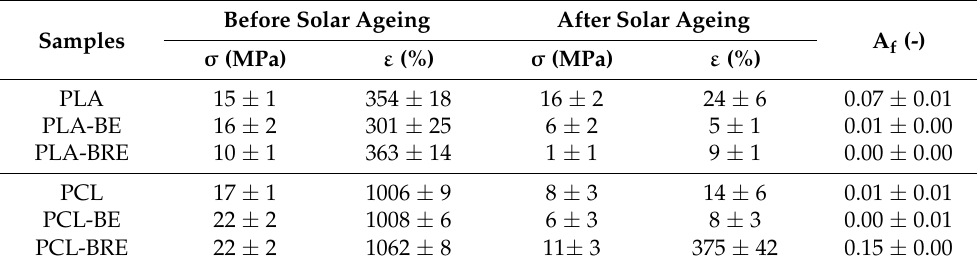
Figure 8. Mechanical properties of the PLA and PCL samples as per maximum stress. Table 4. Comparison of the mechanical properties of the PLA and PCL composites prior to and following ageing; the ageing factor (A f ) was calculated according to Equation (1).